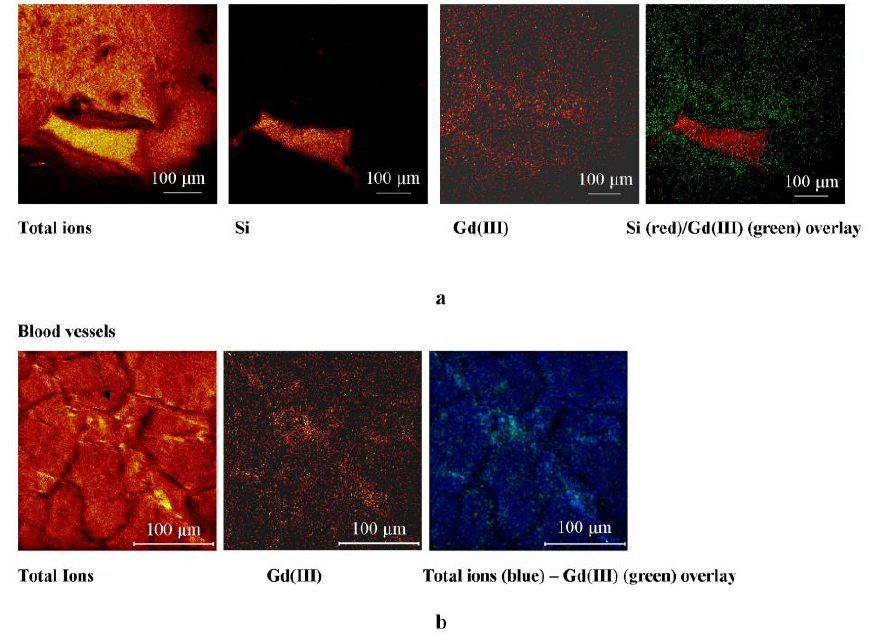
Figure 4. ToF-SIMS maps of non-ischemic tissue: ( a ) Heart tissue section close to the ventricle (image area: 700 × 700 µm); ( b ) heart tissue section near blood vessels (image area: 250 × 250 µm).